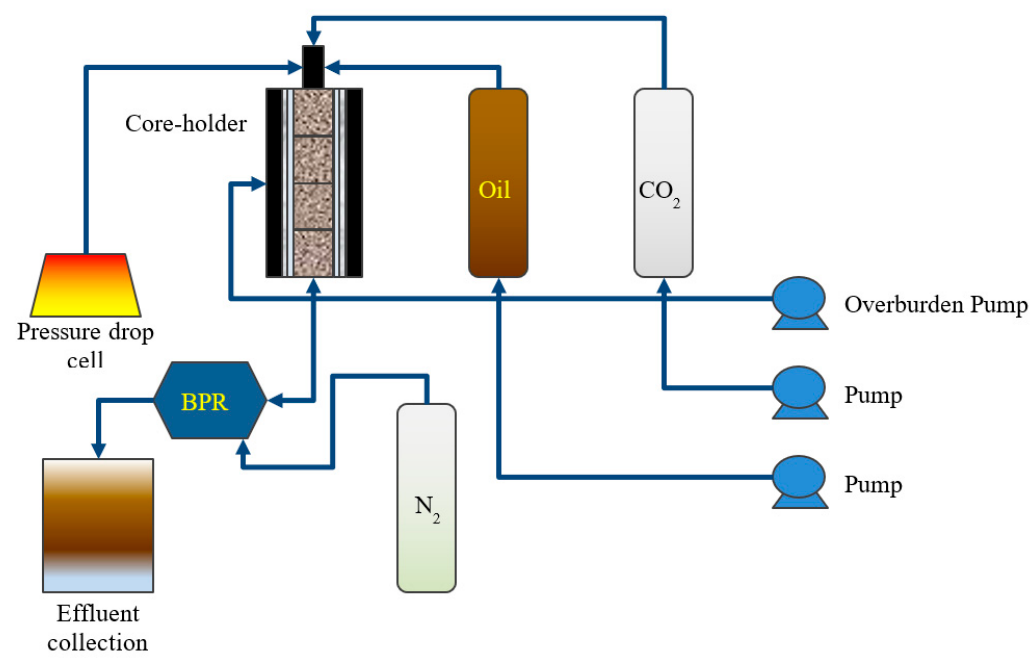
Figure 6. Experimental setup for core characterization and injection flooding.